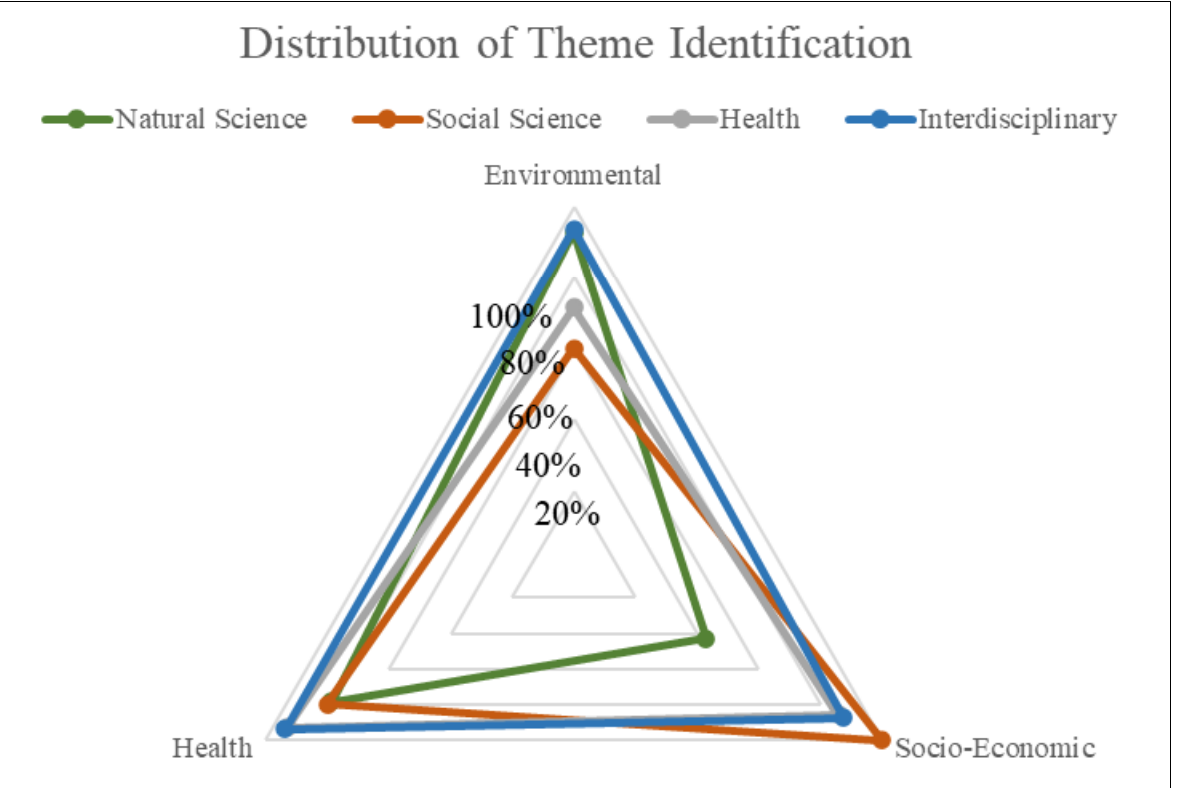
Figure 3. Percent of Papers in Each Discipline Category Identifying at Least One Outcome Within the Three